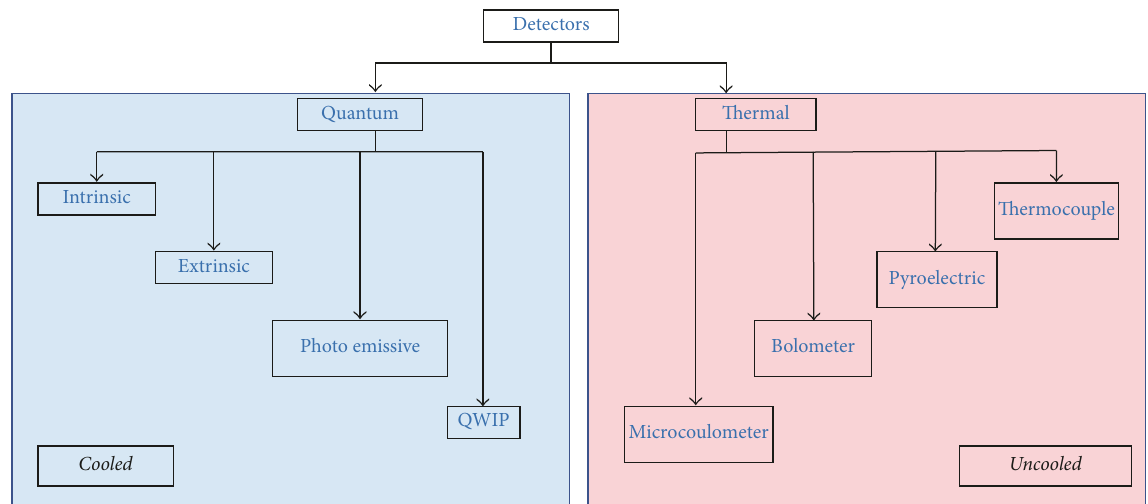
Figure 1: Types of IR detectors.